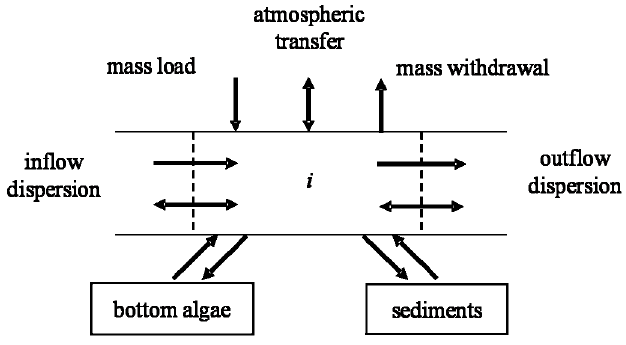
Figure 2. Flow diagram of the mass balance for relevant components of the river system in reach i